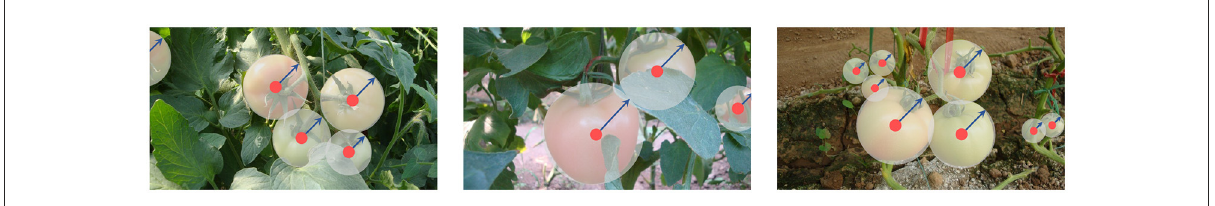
FIGURE1 A tomato is modeled as a center point of its bounding circle. The radius of the bounding circle can be inferred from the keypoint at the